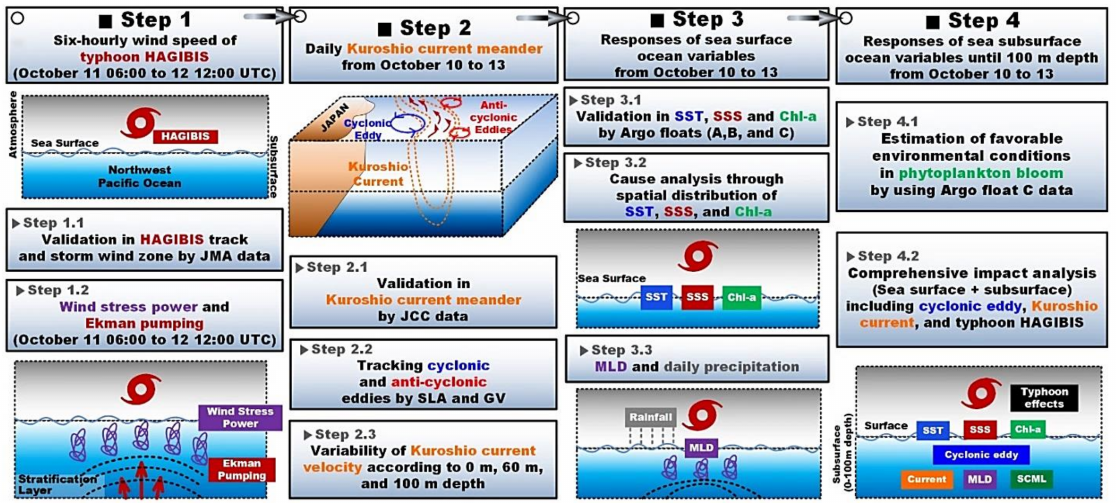
Figure 2. Flowchart depicting the individually-estimated physical and biological mechanisms at the environment of the Northwest Pacific Ocean in response to typhoon HAGIBIS.